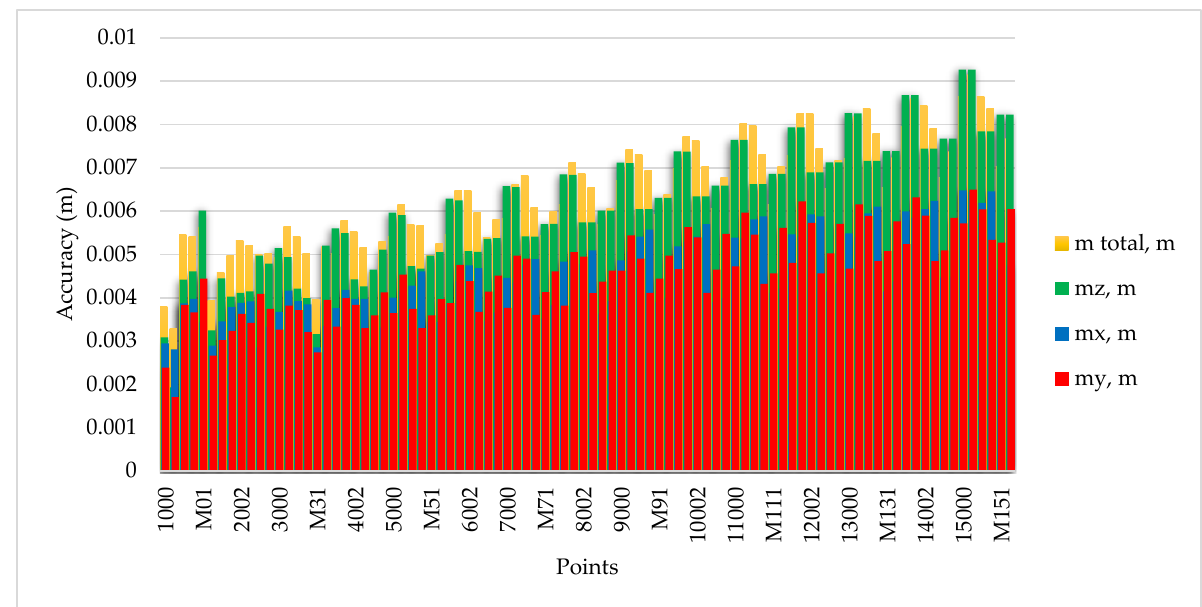
Figure 27. Accuracy of absolute coordinate determination without additional GNSS observations.